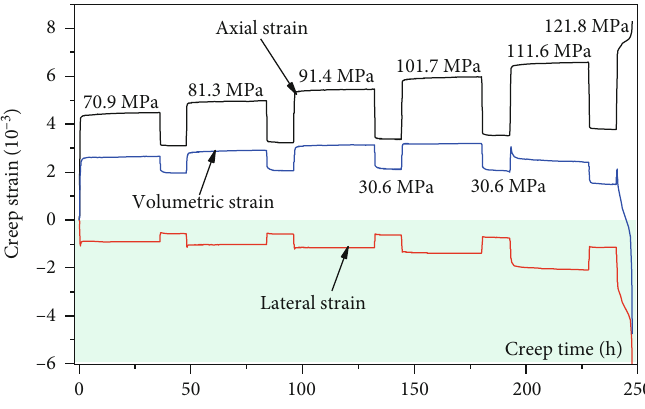
= 6MPa , Δ P = 1 : 9 MPa ). Figure 5: Strain-time curves ( σ 3 Table 1: The axial strain of deviatoric stress of 30.6MPa during cycle loading.